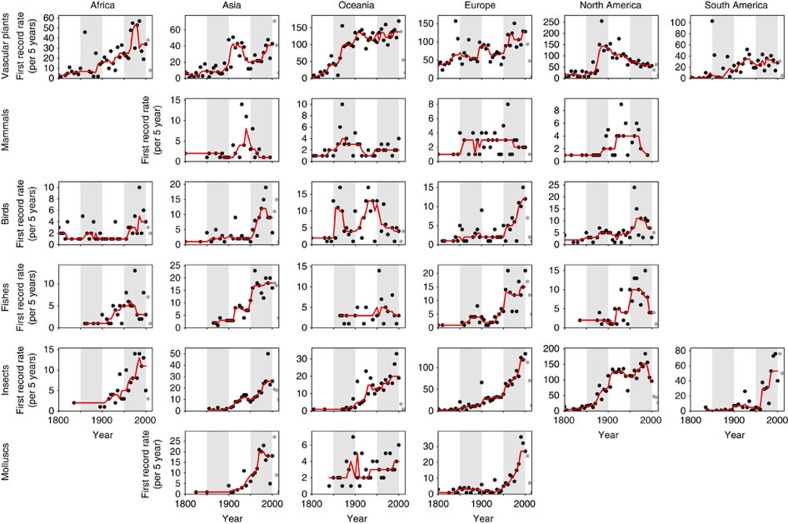
Temporal trends in continental first record rates.Temporal trends in continental first record rates (that is, first records of established alien species on a continent per 5 years, dots) for various taxonomic groups and continents (for delineation of continents see Supplementary Fig. 12). It is noteworthy that for the inter-continental comparison, we only considered first records of established alien species on a continent, to avoid a bias due to varying numbers of countries in a continent, which resulted in a reduced number of first records (56% of the full data set). The trends are indicated by a running median with 25-year moving window (red line). Data after 2000 (grey dots) are incomplete and were removed from analysis. Time series with <70 first records are not shown. For visualization, 50-year periods are distinguished by white/grey shading. Time series for taxonomic groups with low numbers of first records are shown in Supplementary Fig. 6.